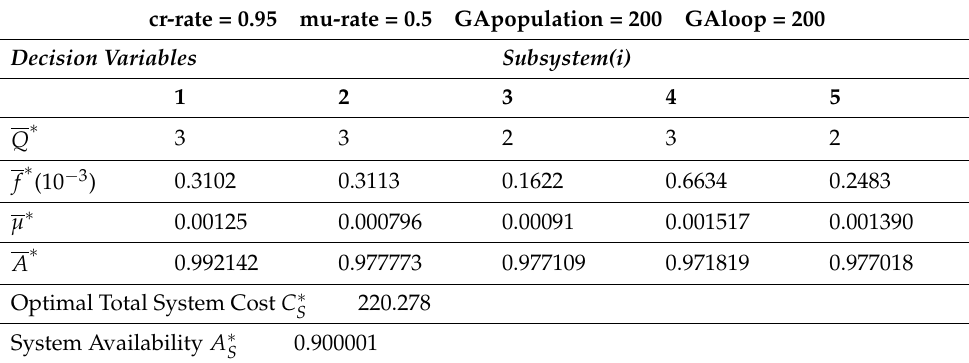
Table 16. Optimal Solutions obtained by ENUM–MGA for parallel-series system.